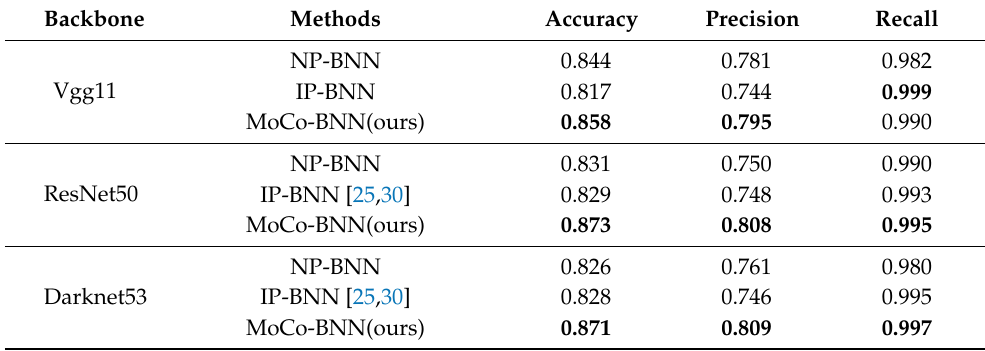
Table 2. Results for BNN patch-matching on QXS-SAROPT with different pre-training methods. Backbone